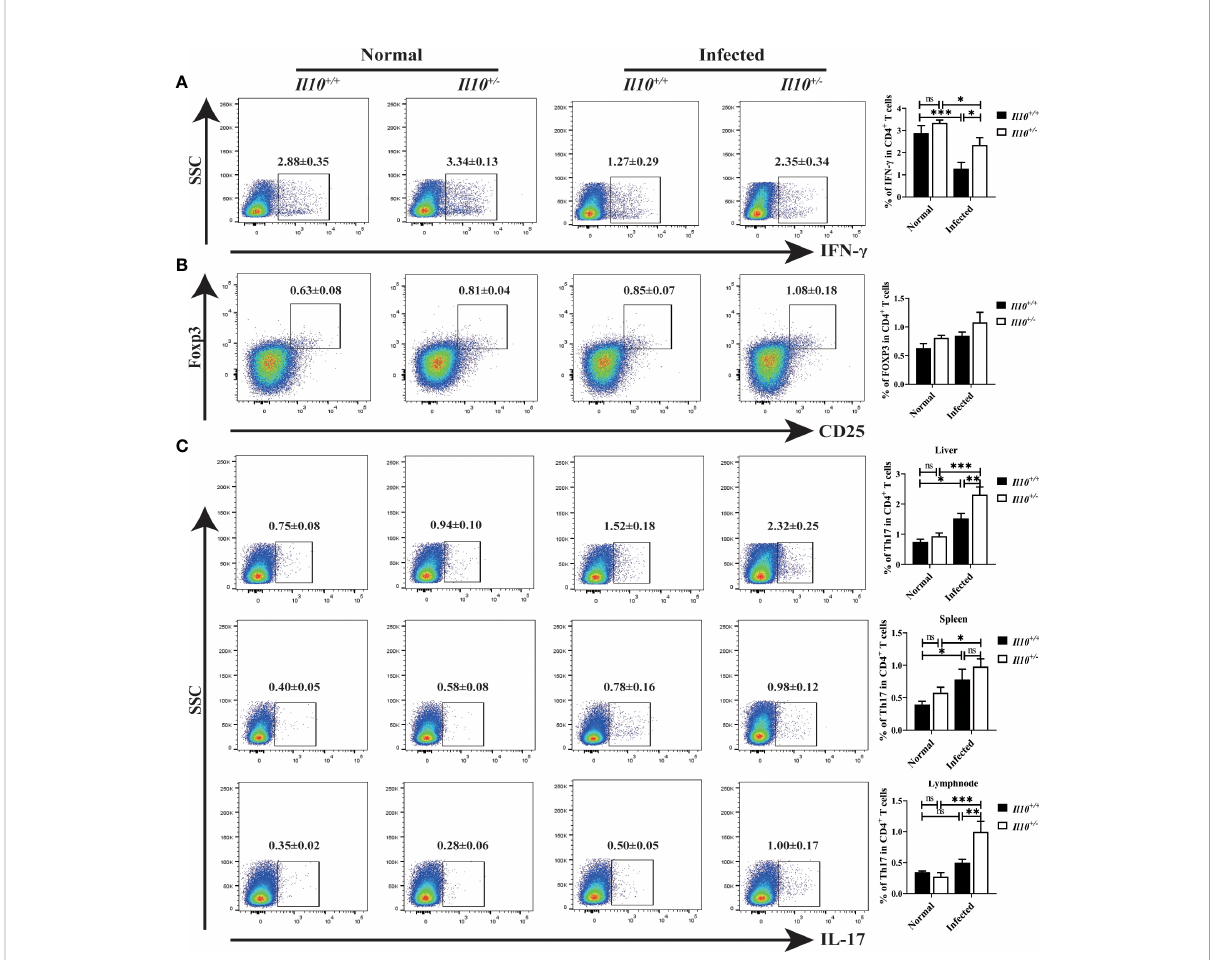
FIGURE 3 IL-10 de fi ciency promotes the ratio of Th17 in clonorchiasis of Il10 +/- mice. (A) The percent of IFN- g + cells in CD4 + T cells in the liver was analyzed by fl ow cytometry (the left panel). The right panel shows the ratio of Th1 cells in CD4 + T cells. (B) The percent of CD25 + Foxp3 + cells in CD4 + T cells in the liver was analyzed by fl ow cytometry (the left panel). The right panel shows the ratio of CD25 + Foxp3 + Treg cells in CD4 + T cells. (C) The percent of IL-17 + cells in CD4 + T cells in the liver, spleen, and lymph node were analyzed by fl ow cytometry (the left panel). The right panel shows the ratio of Th17 cells in CD4 + T cells. Compared with indicated group, * P < 0.05, ** P < 0.01, *** P < 0.001, ns, no signi fi